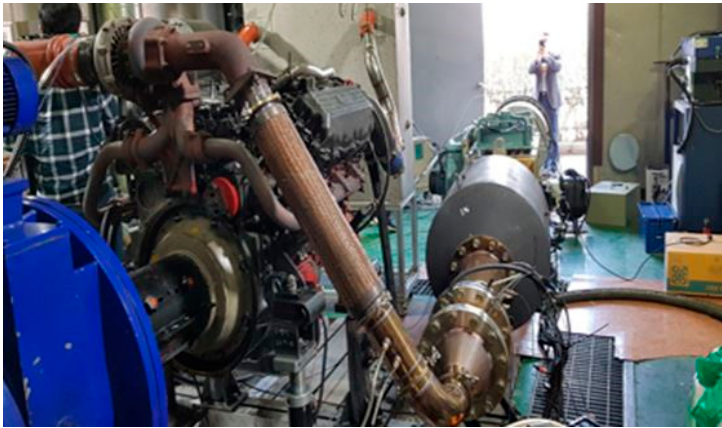
Figure 14. Back pressure test rig: circle-type system. Table 4. CFD and experimental back pressure test results.